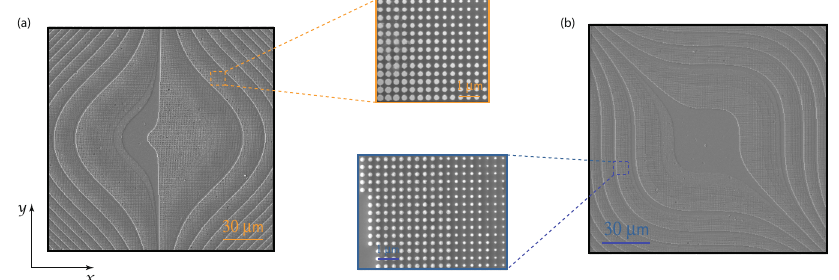
Figure 2. Scanning electron micrographs of fabricated devices coated in gold. Half of the Alvarez lens is shown in ( a ), and the cubic phase plate is shown in ( b ). Insets are zooms of specific locations of the metasurface showing the gradient in pillar